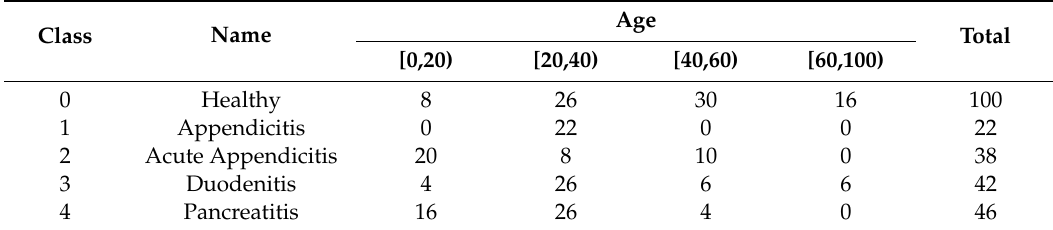
Table 2. Sample distribution of the